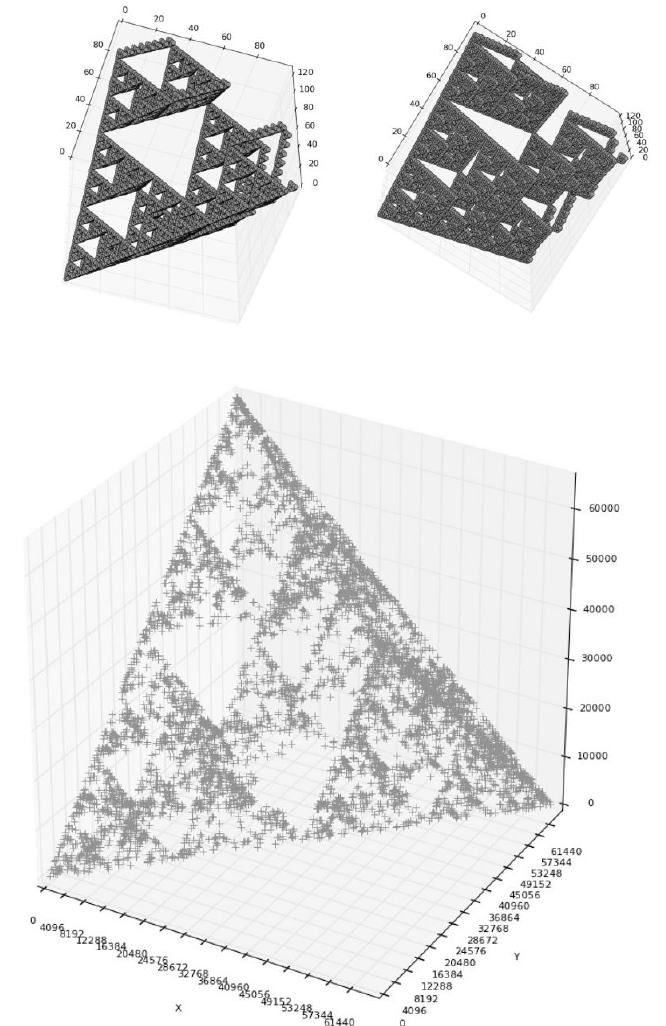
Figure 13. Upper level: two 2-dimensional images of an “ideal” 3d configuration in its examination from two oblique foreshortening; Lower level: a real 3d configuration for a real nucleotide sequence (see explanation in text).